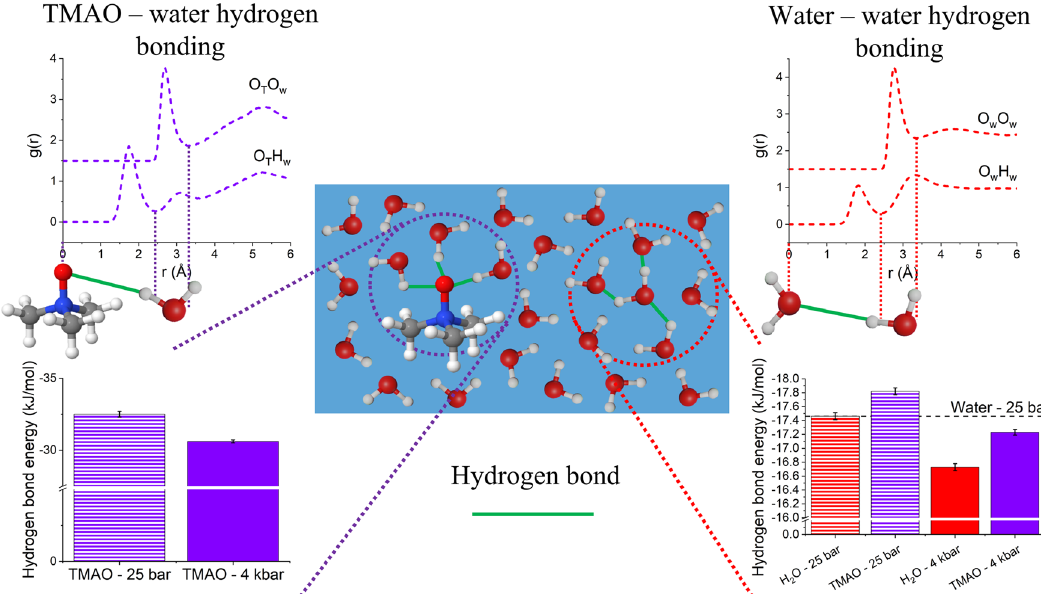
Fig. 5 Hydrogen bonding in aqueous TMAO. A schematic showing the hydrogen bonding between water and a central TMAO oxygen (purple circle) and between water and a central water molecule (red circle) with the associated radial distribution functions, g(r), and calculated average hydrogen bond interaction